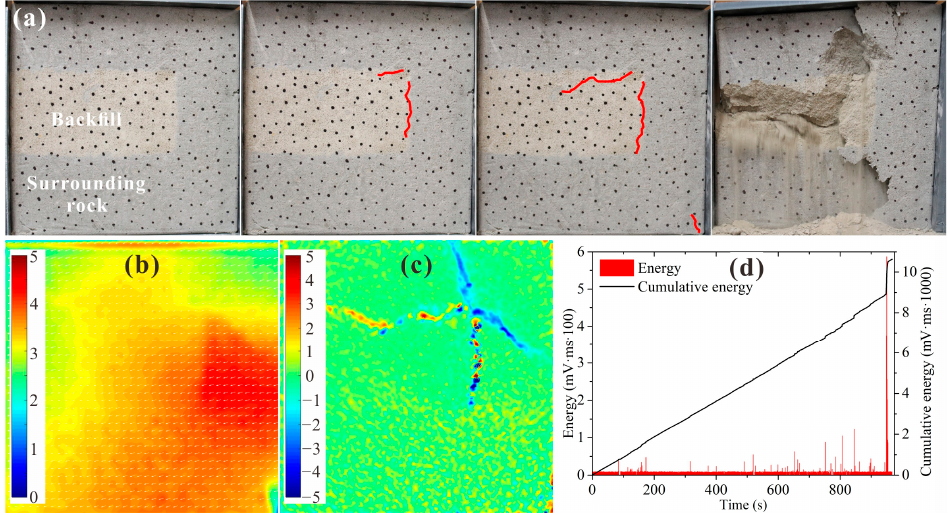
Figure 11. Experimental results for type C. ( a ) Damage and failure processes; ( b ) displacement field; ( c ) strain field; ( d ) acoustic emission energy.